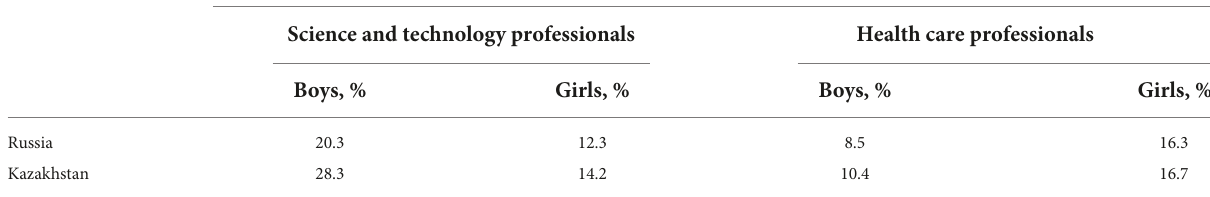
TABLE 6 Assessment of the influence of social motive on adolescents’ performance according to the results of PISA 2018 (OECD, 2019). Country Percentage of top performers in science or mathematics who expect to work as. when they turn